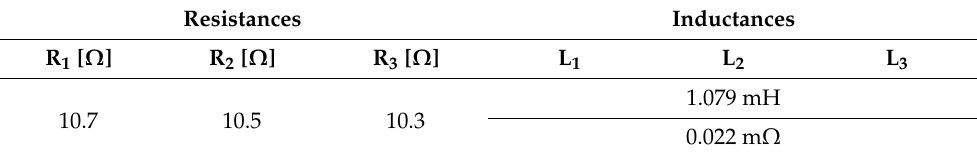
Figure 5. The voltage and current waveforms ( a ) for the OVT inverter under a resistive load and their spectra ( b ).